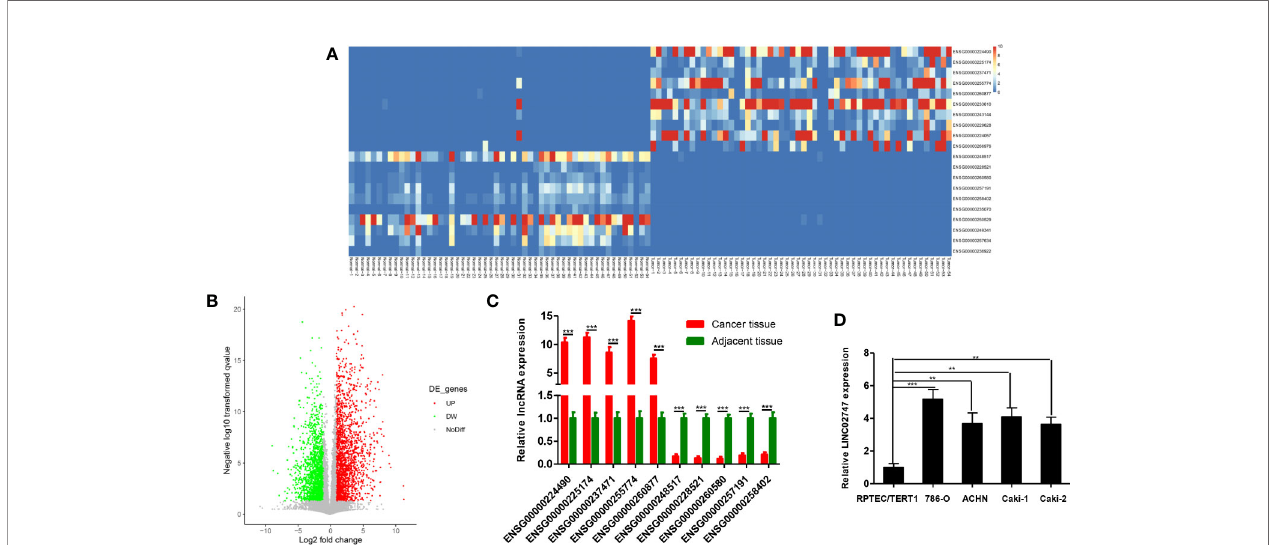
FIGURE 1 | (A) Heatmap showing differentially expressed miRNAs based on 54 pairs of ccRCC tissues and matched para-carcinoma tissues in TCGA dataset (Fold Change ≥ 4 and P < 0.01). (B) Volcano plots were constructed based on TCGA (fold-change > 2.0 and P < 0.05). The red points represent differentially upregulated genes, and green points represent downregulated genes. (C) Validation of the lncRNAs in 20 pairs of cancer tissues and matched para-carcinoma tissues by qRT- PCR. (D) The expression of LINC02747 was detected by qRT-PCR in normal kidney cells (RPTEC/TERT1) and RCC cells (786-O, ACCN, Caki-1, and Caki-2). (*** P < 0.001, ** P < 0.01, * P <